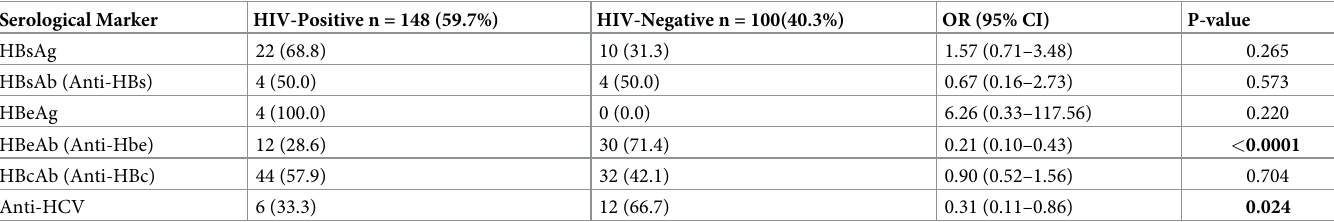
Table 2. The prevalence of HBV and HCV serological markers stratified by the HIV status. Serological